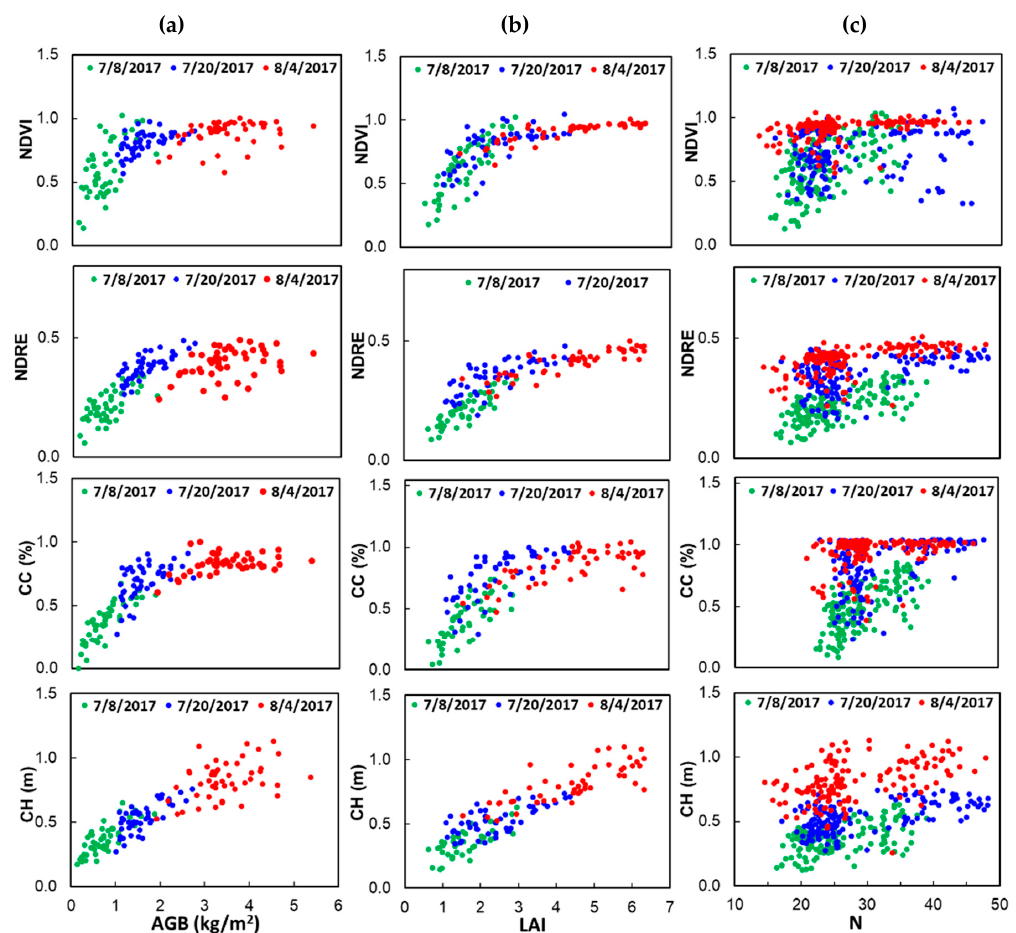
Figure 8. Scatter plots of aboveground biomass (AGB) ( a ), LAI ( b ), and N ( c ) against crop spectral and structural features; NDVI is normalized difference vegetation index, NDRE is normalized difference red-edge index, CC is canopy coverage in percentage, and CH is canopy height in meter; Green dots represent the data from July 8, blue dots represent the data from July 20, and red dots represent the data from August 4 of 2017. Spectral features NDVI and NDRE presented saturation pattern, while CH demonstrated higher responsiveness with the increase of AGB, LAI, and N.